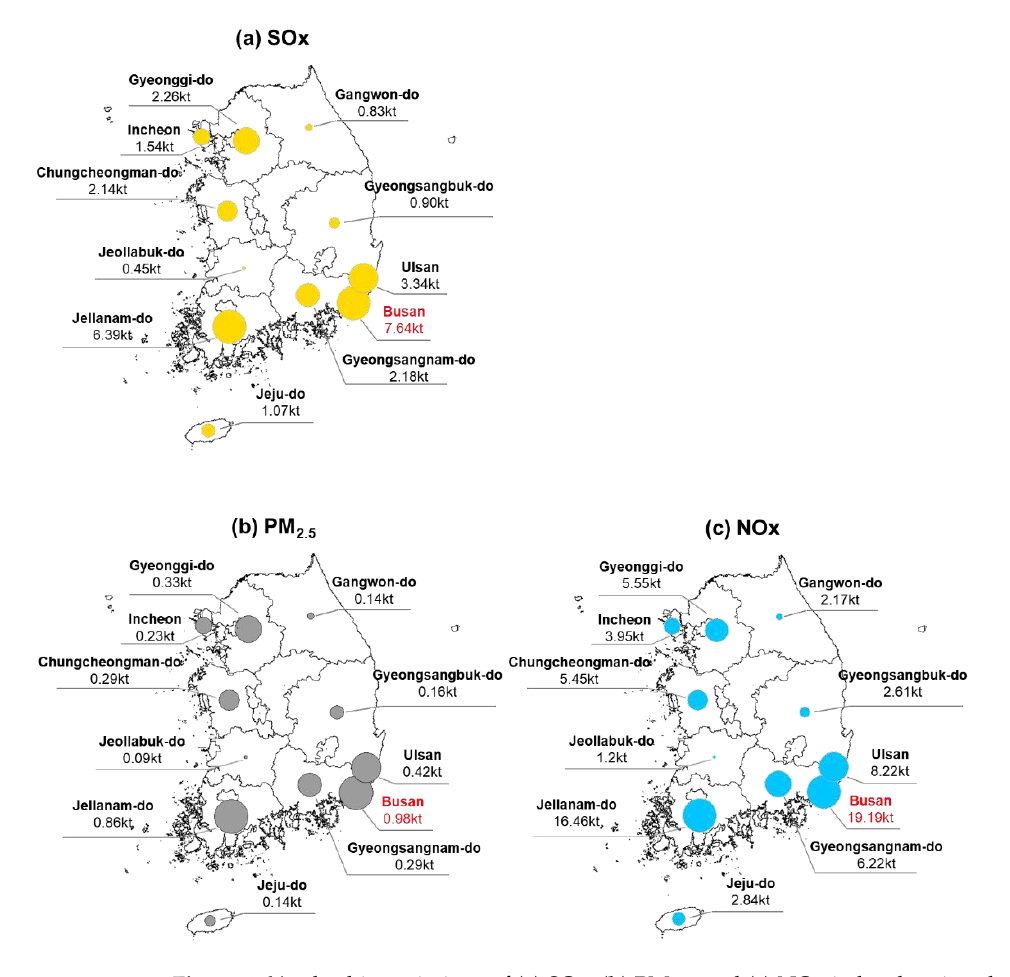
Figure 4. Yearly ship emissions of ( a ) SOx, ( b ) PM 2.5, and ( c ) NOx in local regions based on CAPSS 2016 (unit: kiloton, kt).